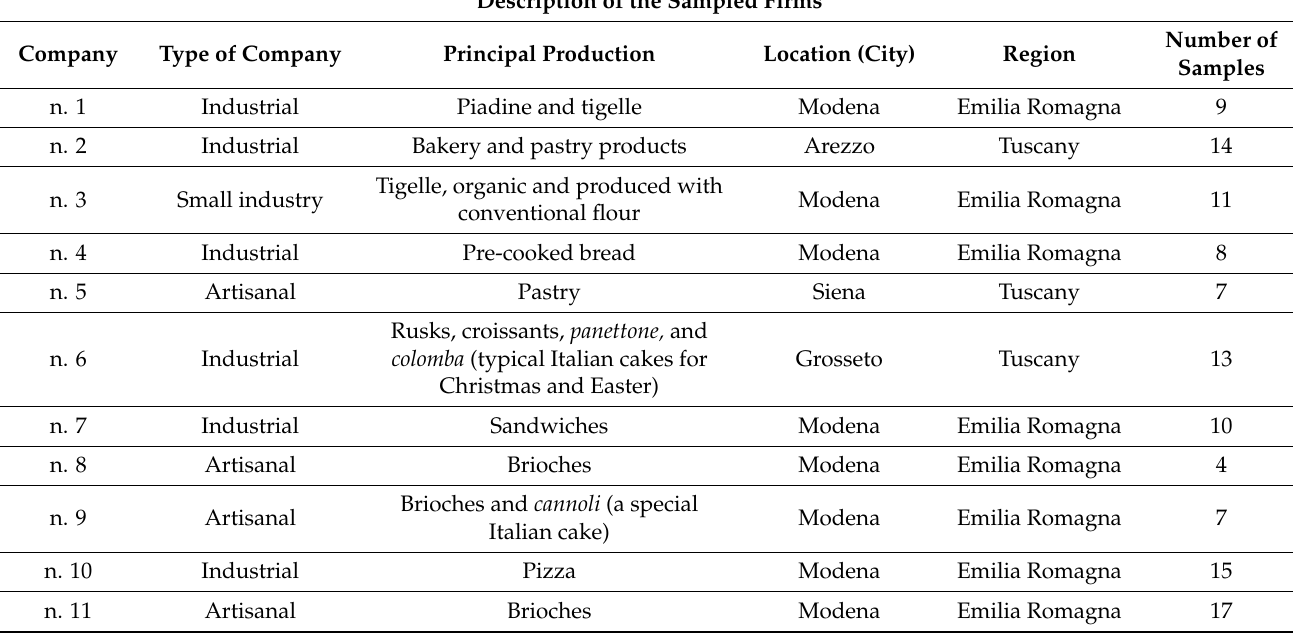
Table 2. Principal characteristics of the sampled